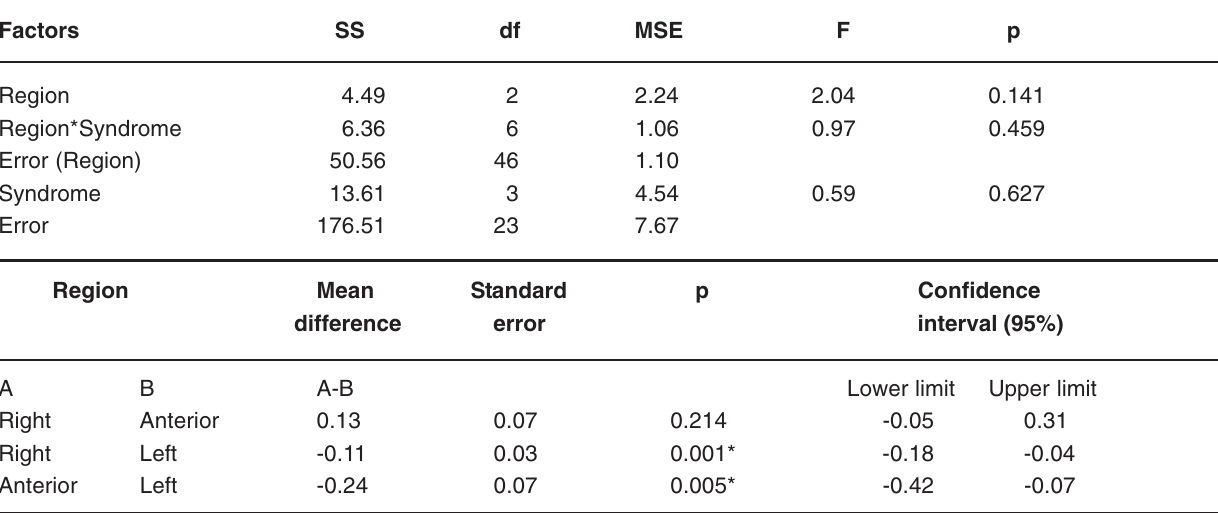
TABLE 6- Comparison of keratinized mucosa according to region and